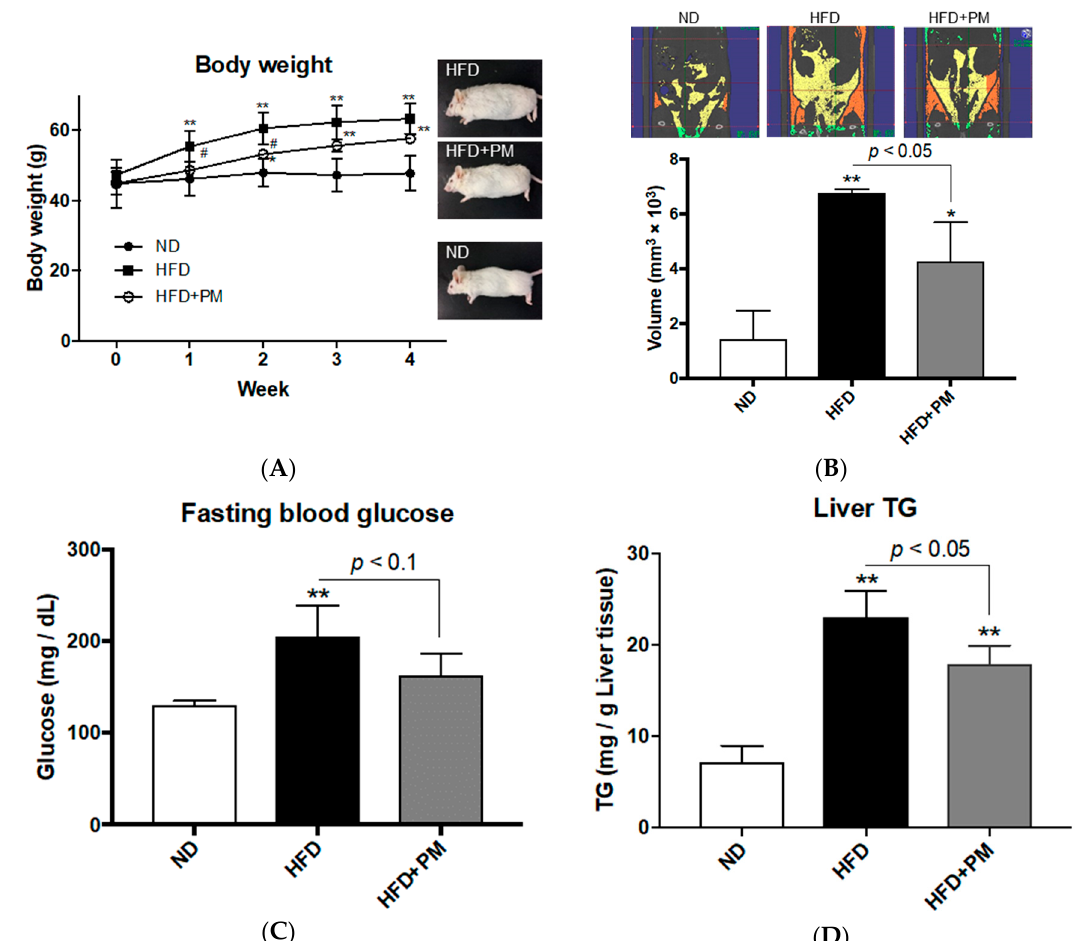
Figure 3. PM administration in NSY/HOS mice fed on a high fat diet. ( A ) NSY/HOS Mice fed on a high fat diet (HFD; closed squares) gained weight during the experiment. PM (open circles) suppressed body weight gain up to week 2. ( B ) Visceral adipose tissues (VAT) in week 6. HFD increased VAT compared to that of mice fed on a normal diet (ND), and PM significantly suppressed VAT increase. In the upper panel, yellow and orange colors indicate VAT and subcutaneous adipose tissues (SCAT), respectively. ( C ) Fasting blood glucose (FBG) levels in week 4. ( D ) PM suppressed liver TG increase in the HFD group. * p < 0.05, ** p < 0.01 vs. ND. # p < 0.05 between HFD and HFD + PM. n = 6, error bars indicate SD.